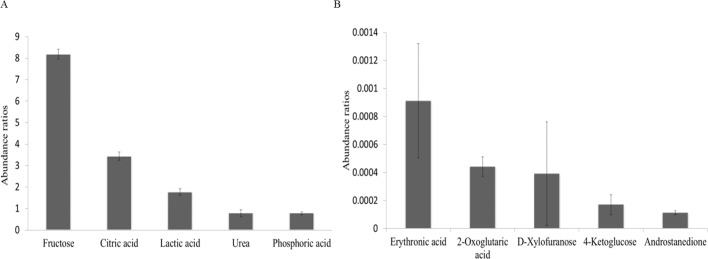
Abundance ratios of the most and least predominant metabolites present in bull seminal plasma.(A) The five most abundant metabolites were fructose, citric acid, lactic acid, urea and phosphoric acid and (B) the five least metabolites were identified as androstenedione, 4-ketoglucose, D-xylofuranose, 2-oxoglutaric acid and erythronic acid. Abundance ratio of the metabolites was calculated by dividing abundance of target ions of metabolites by that of target ion of the internal standard. Error bars represent standard error of the mean.